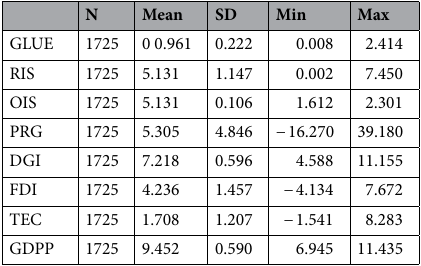
Table 2. Descriptive statistics of